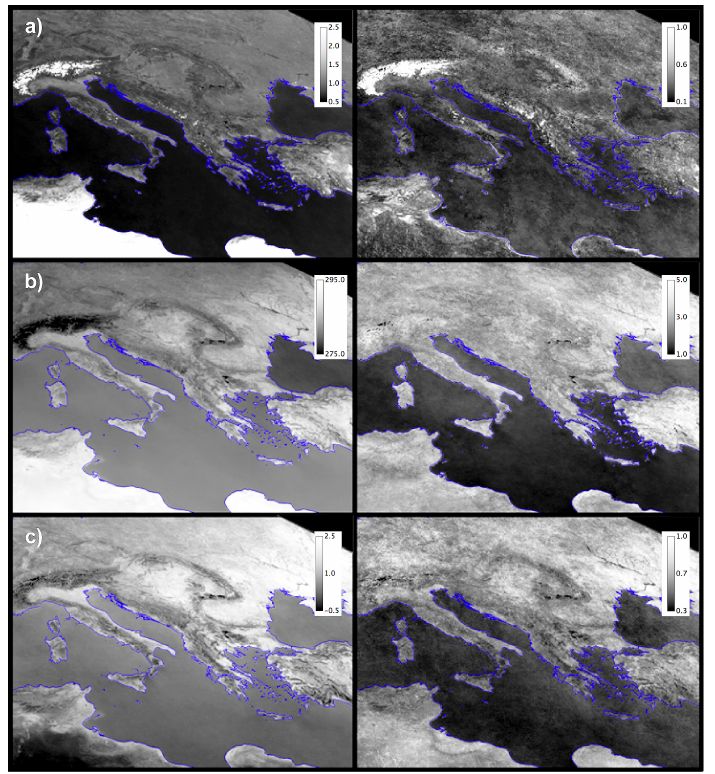
Figure 1. Spectral reference fields of temporal mean (left panels) and standard deviation (right panels) generated processing MSG-SEVIRI data at 06:00 UTC (725 × 533 pixels in size) acquired in May; ( a ) VIS channel (i.e., radiance measured at 0.6 μ m wavelength); ( b ) TIR channel ( BT at 11 μ m wavelength); ( c ) BTD ( BT11-BT12 ).